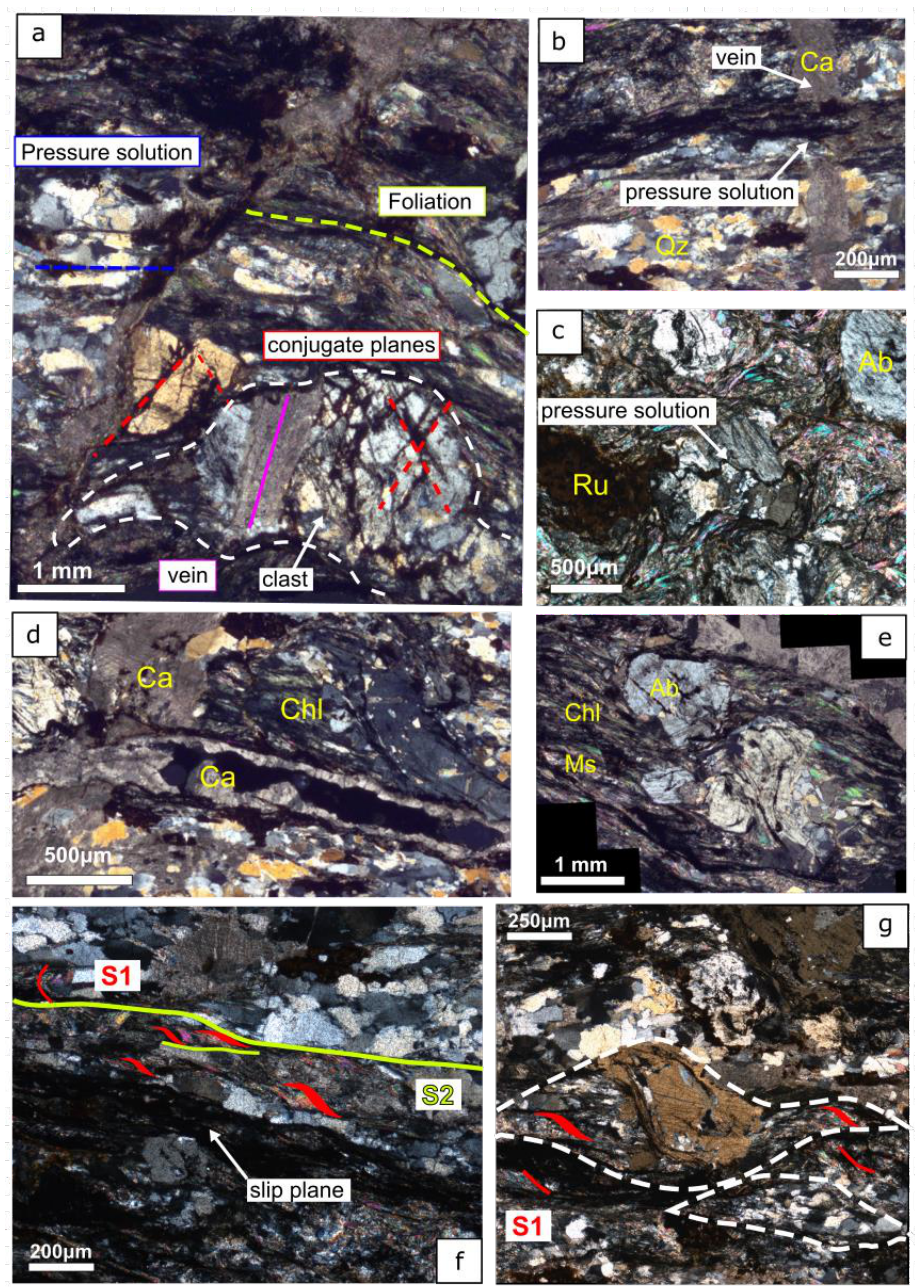
Figure 6. Thin sections under cross-polarized light; ( a ) D3 foliation of the fault core (blue line), with high angle fractures (red) and pressure solution planes (in yellow) from which the orientation of the paleostress field, with a near-vertical maximum principal axis, can be derived. A composite clast is outlined, containing a fragment of a calcite vein; ( b ) pressure-solution vein cutting a calcite vein; ( c ) detail of the pressure solution affecting two composite clasts: in the lower individual minerals can still be observed; ( d ) cross-cutting relationship between two calcite veins; the horizontal vein probably used an older pressure-solution plane filled with chlorite; ( e ) Euhedral feldspars within intense foliation parallel to the orientation of the fault core. ( f ) previous S1 foliation deformed by the younger S2 foliation (see Campani et al. 2010 [35] and Montemagni and Zanchetta 2022 [41] for similar features) and the slip plane developed along a pressure solution plane; ( g ) sigmoidal clasts made of feldspar and quartz, deformed by the younger S1 foliation and shear deformation along S1. Within the clast, an inter-tectonic foliation can be identified.